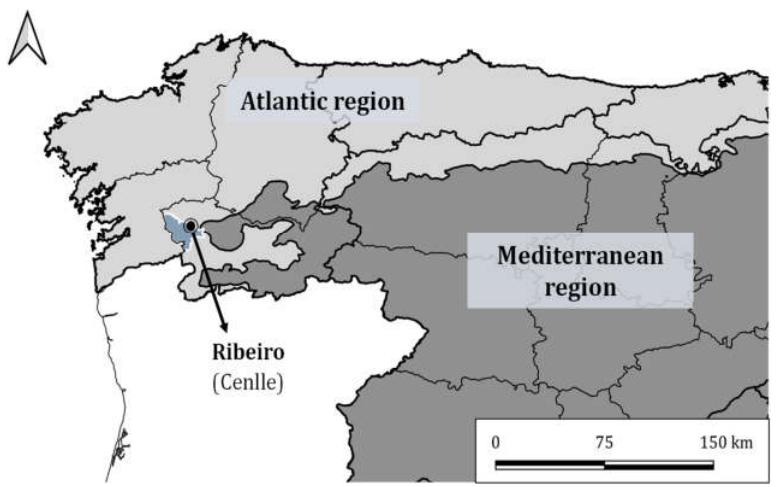
Figure 1. Location map of the studied vineyard in Cenlle, in the Ribeiro PDO situated at northwest Spain. Figure obtained by QGIS 3.10.14 software. Shapefile of biogeographic regions from MITECO [24].